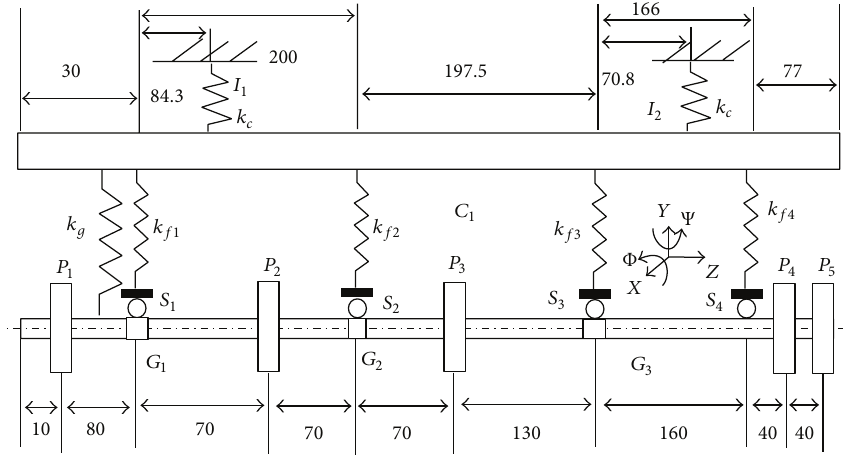
Figure 1: Rotor-bearing-casing model sketch map of a type of aeroengine (unit: mm).